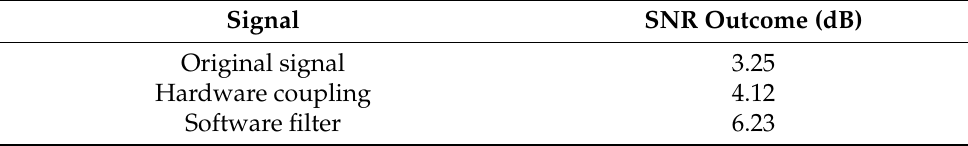
Table 2. Signal type vs. SNR